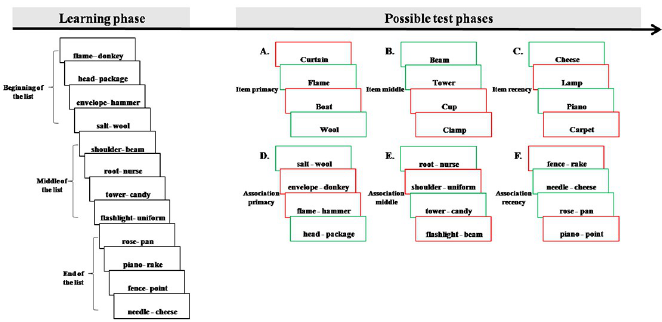
Fig 1. A description of the experimental paradigm. 24 separate lists of 12 pairs of words were used. Each list was then immediately followed by only one of six (A-F) tests options (3 (stimuli serial position) X 2 (test) ). The four replications for each of the six conditions were presented randomly across participants and each stimulus was used only for one of the tests (i.e., each stimulus was only used once in the experiment). Green rectangles represent targets while red rectangles represent